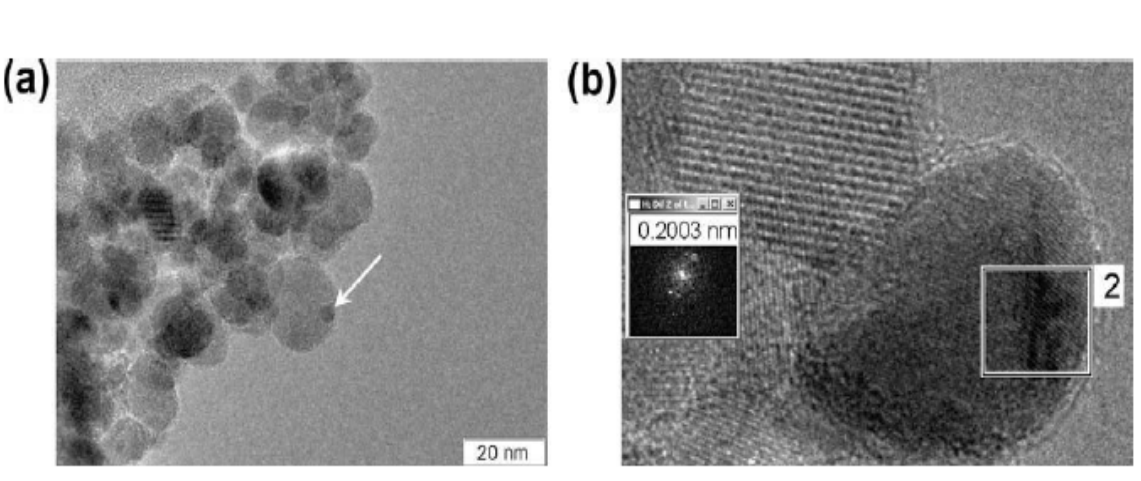
Figure 4. TEM image showing the palladium nanoparticles adsorbed onto the magnetic nanoparticles (a) and HRTEM image showing the lattice fringes of the palladium nanoparticles as well as the electron diffraction pattern observed (b) Reprinted from [43] with permission from Elsevier, ©